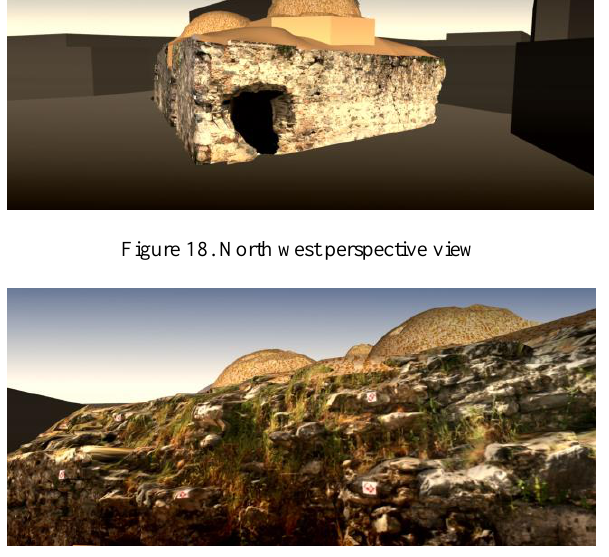
Figure 19. Detailed perspective view